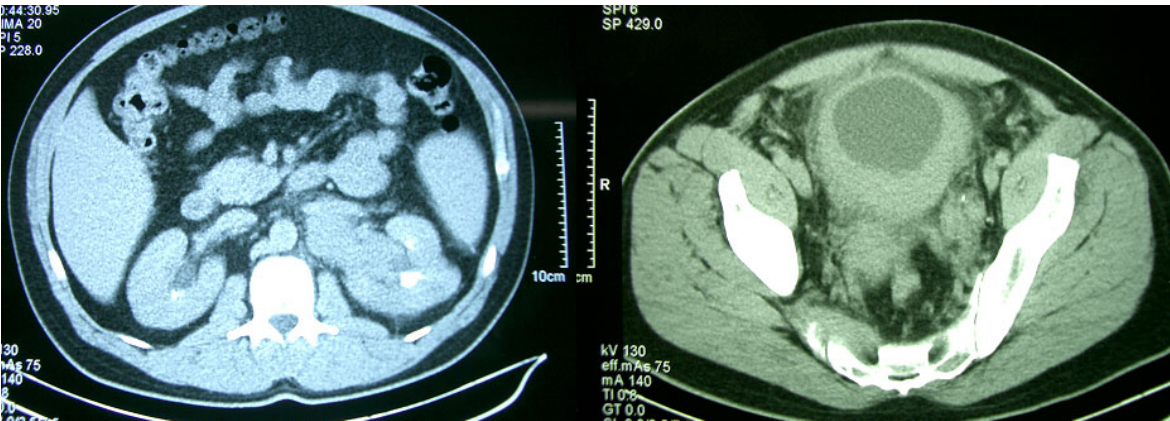
FIGURE 1. Axial computed tomography images demonstrating widespread involvement of the urinary tract by lymphoma causing obstruction (left) with widespread bladder wall involvement (right).